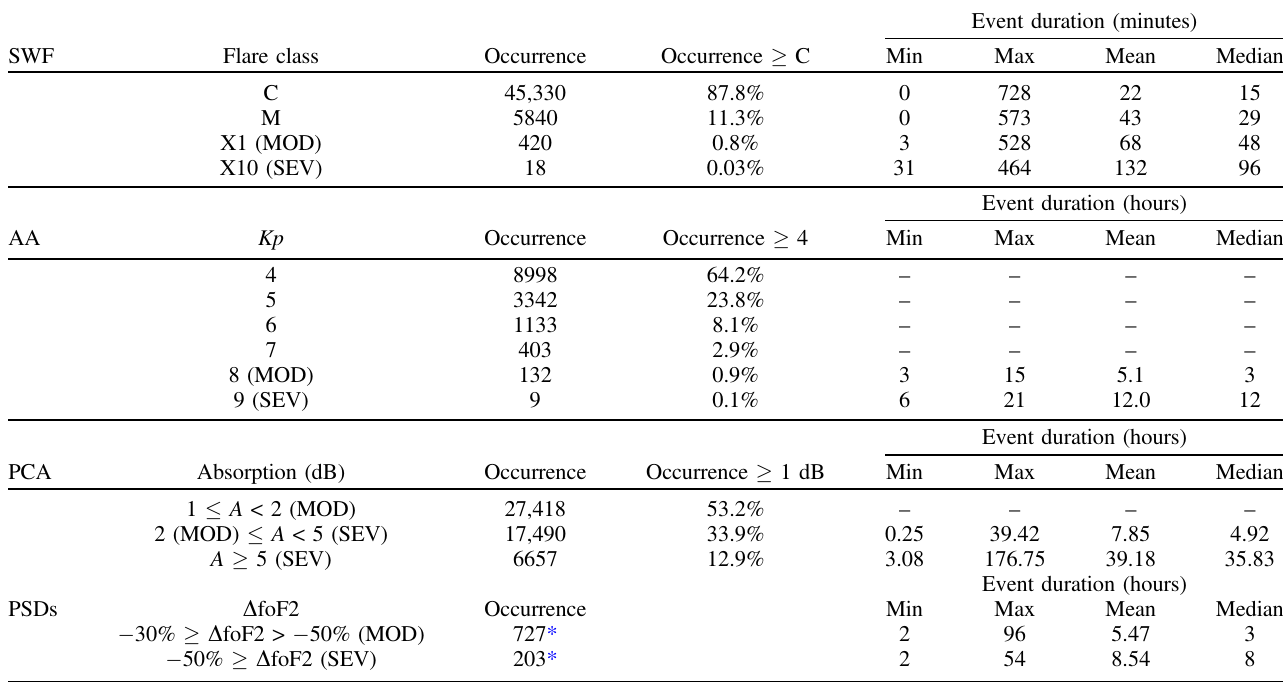
Table 2. Occurrence and duration of SWF, AA, PCA, and PSD events overall and for a subset of MOD and SEV events. See the text for additional